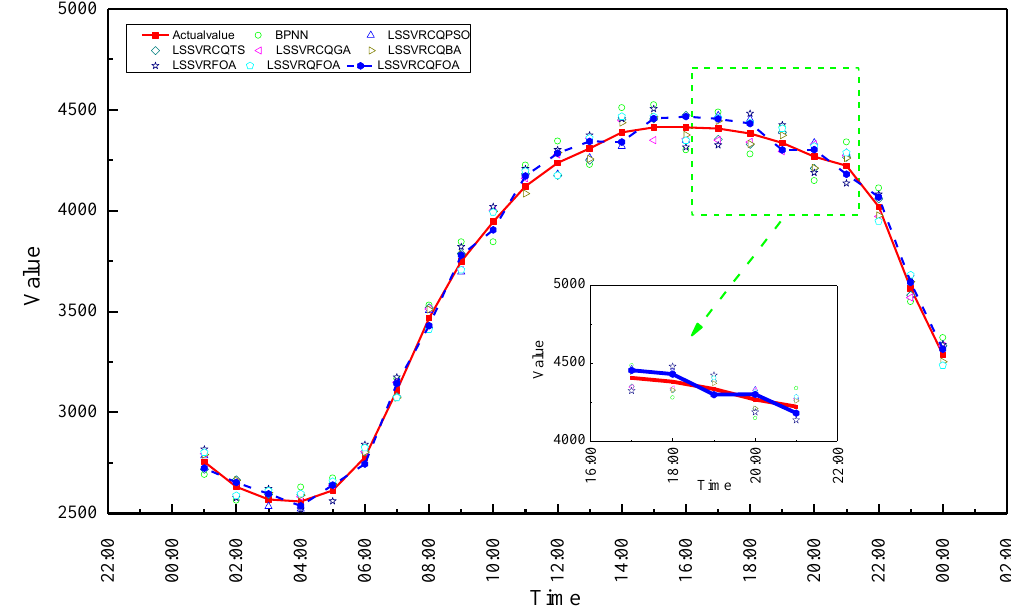
Figure 4. Forecasting values of LS-SVR-CQFOA and other models for GEFCom2014 (July).